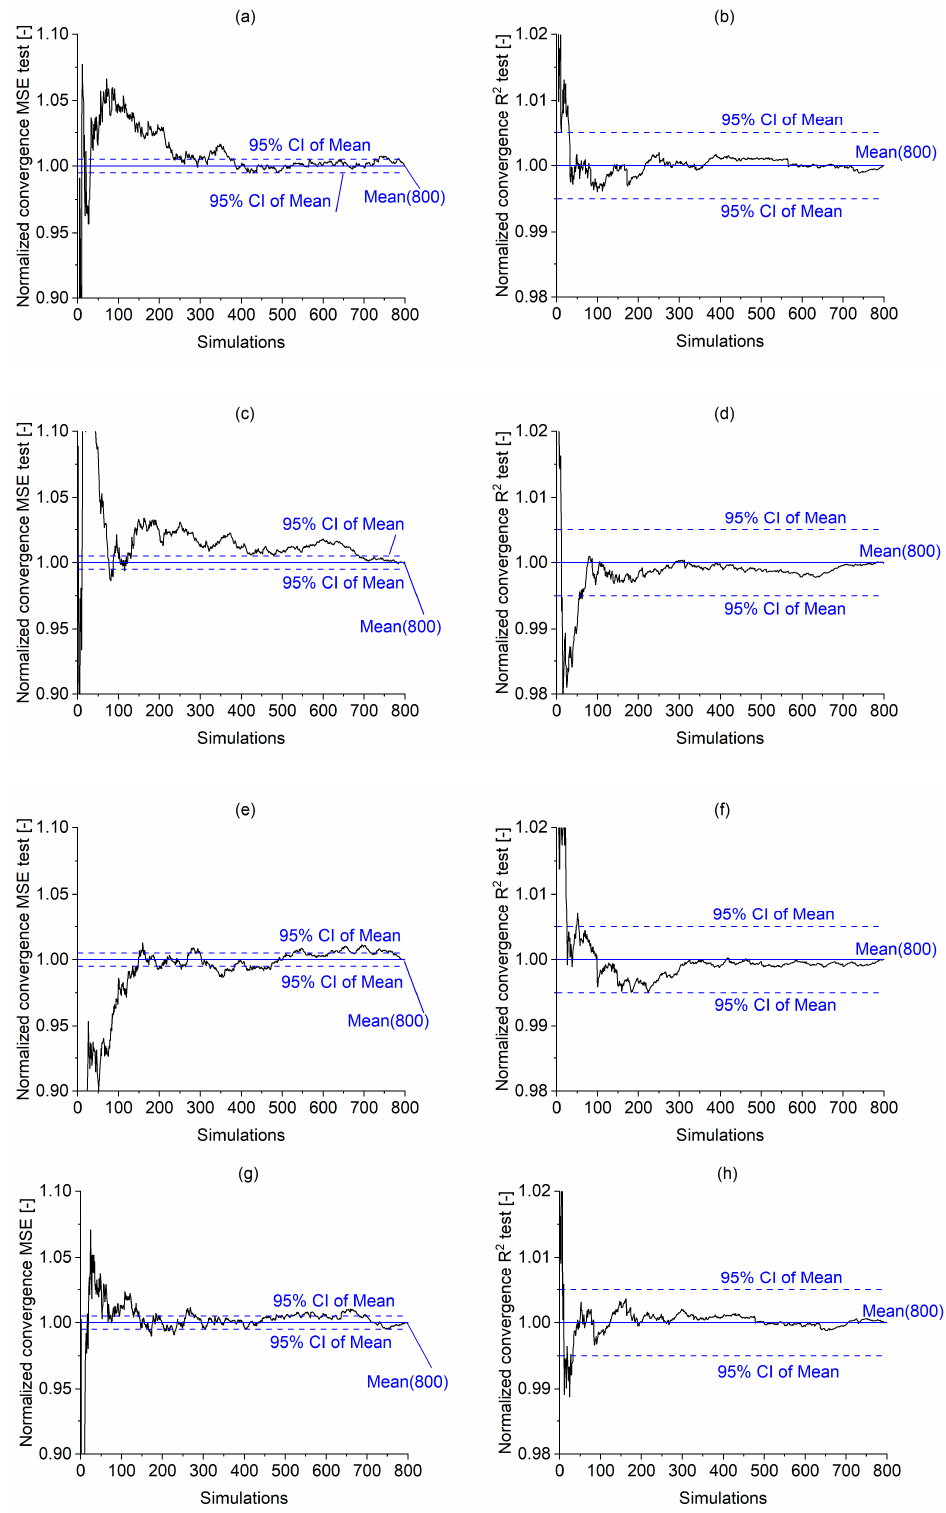
Figure 8. Comparison of the Monte Carlo normalized convergence of testing set MSE and R 2 for selected models: ( a , b ) ET1, ( c , d ) ET2, ( e , f ) ET3, ( g , h ) ET4, ( i , j ) ET5. 6.3. Model Interpretation Based on the previous sections, model ET1 (Table 6) was considered for further anal- ysis. This model was used for the variable importance analysis and model interpretation. The PDP (Figure 9) and ICE plots (Figure 10) were calculated for each input variable. It should be noted that the scale in Figure 9 is different for each variable to show the re- sponse changes in detail. On the other hand, in Figure 10, the scale is the same for all variables. The red line indicates the PDP as an average of all the curves (Figure 10).